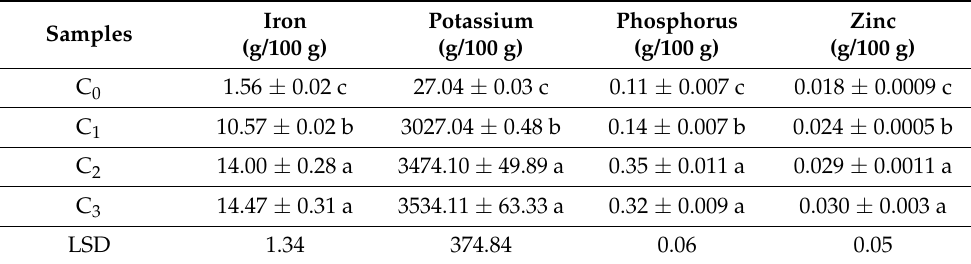
Table 4. Mineral content of cake fortified with MOLP and RBF.